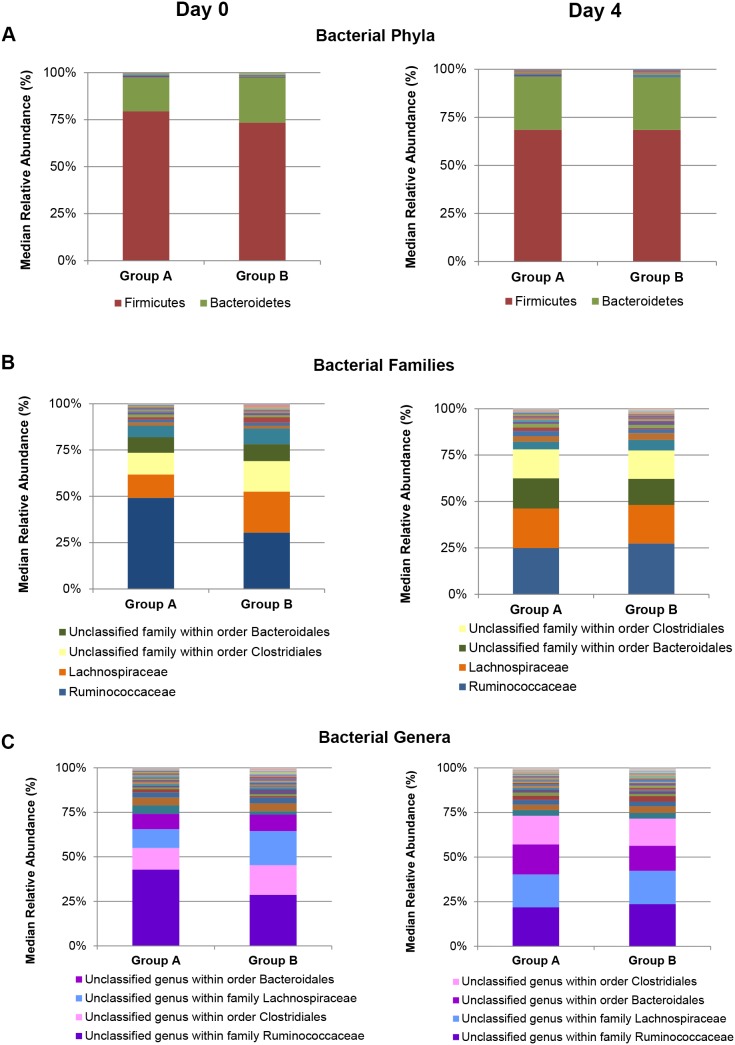
Comparison of the bacterial community structure at multiple levels.The median relative abundances of the bacterial phyla in the faeces of Group A and B horses, on Days 0 and 4, are illustrated in the figure, panel (A). Panel (B) shows the relative abundances of the bacterial families, and panel (C) shows the relative abundances of bacterial genera present in the faeces of Group A and B horses, on Days 0 and 4. The stacked bar graph is presented in ascending order of the median relative abundances of bacterial taxa for Group A horses, and the legends show the most dominant taxa in each graph (>15% median relative abundance for the phylum level and >8% for the family and genus levels).